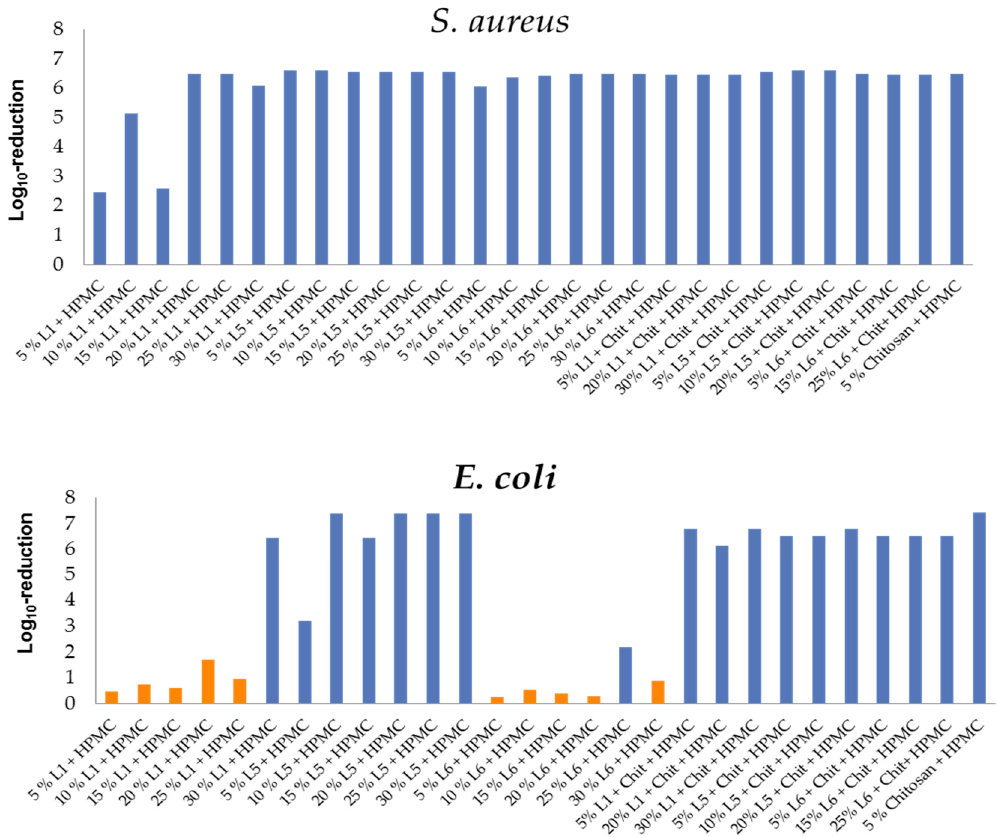
Figure 6. Antimicrobial activity of HMPC / lignin and HPMC / lignin / chitosan films against S. aureus (above) and E. coli (below). All films are active against S. aureus . Columns in orange relate to nonactive films against E. coli . Chitosan incorporation increased the activity. L5 films showed highest activities against both bacteria.